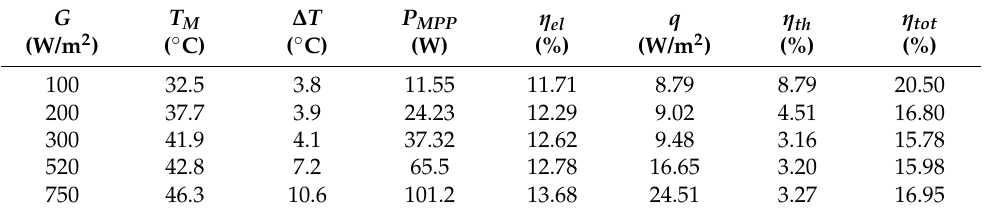
Table 5. Measurement results for the cooling airflow rate 𝑉 (cid:4662) = 9.12 (cid:2923)